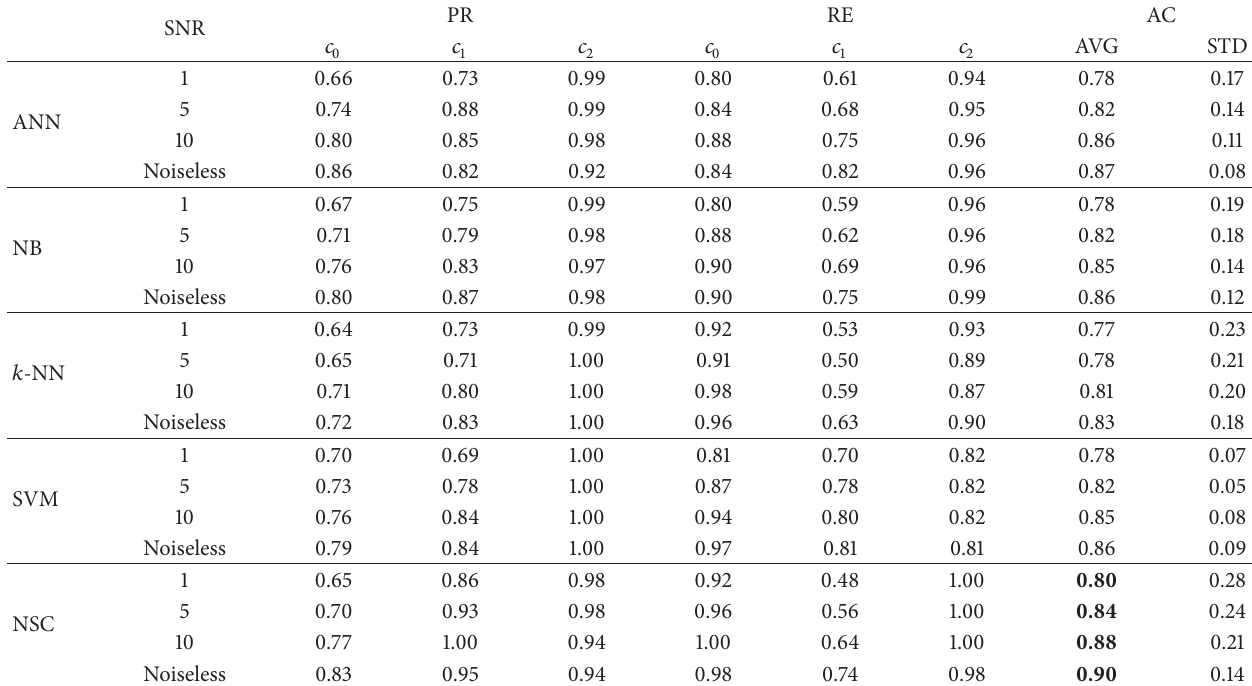
Table 6: Performance of the classifiers with CR = 85.35% for SNR = 1, 5, and 10 dB and noiseless EEG data.